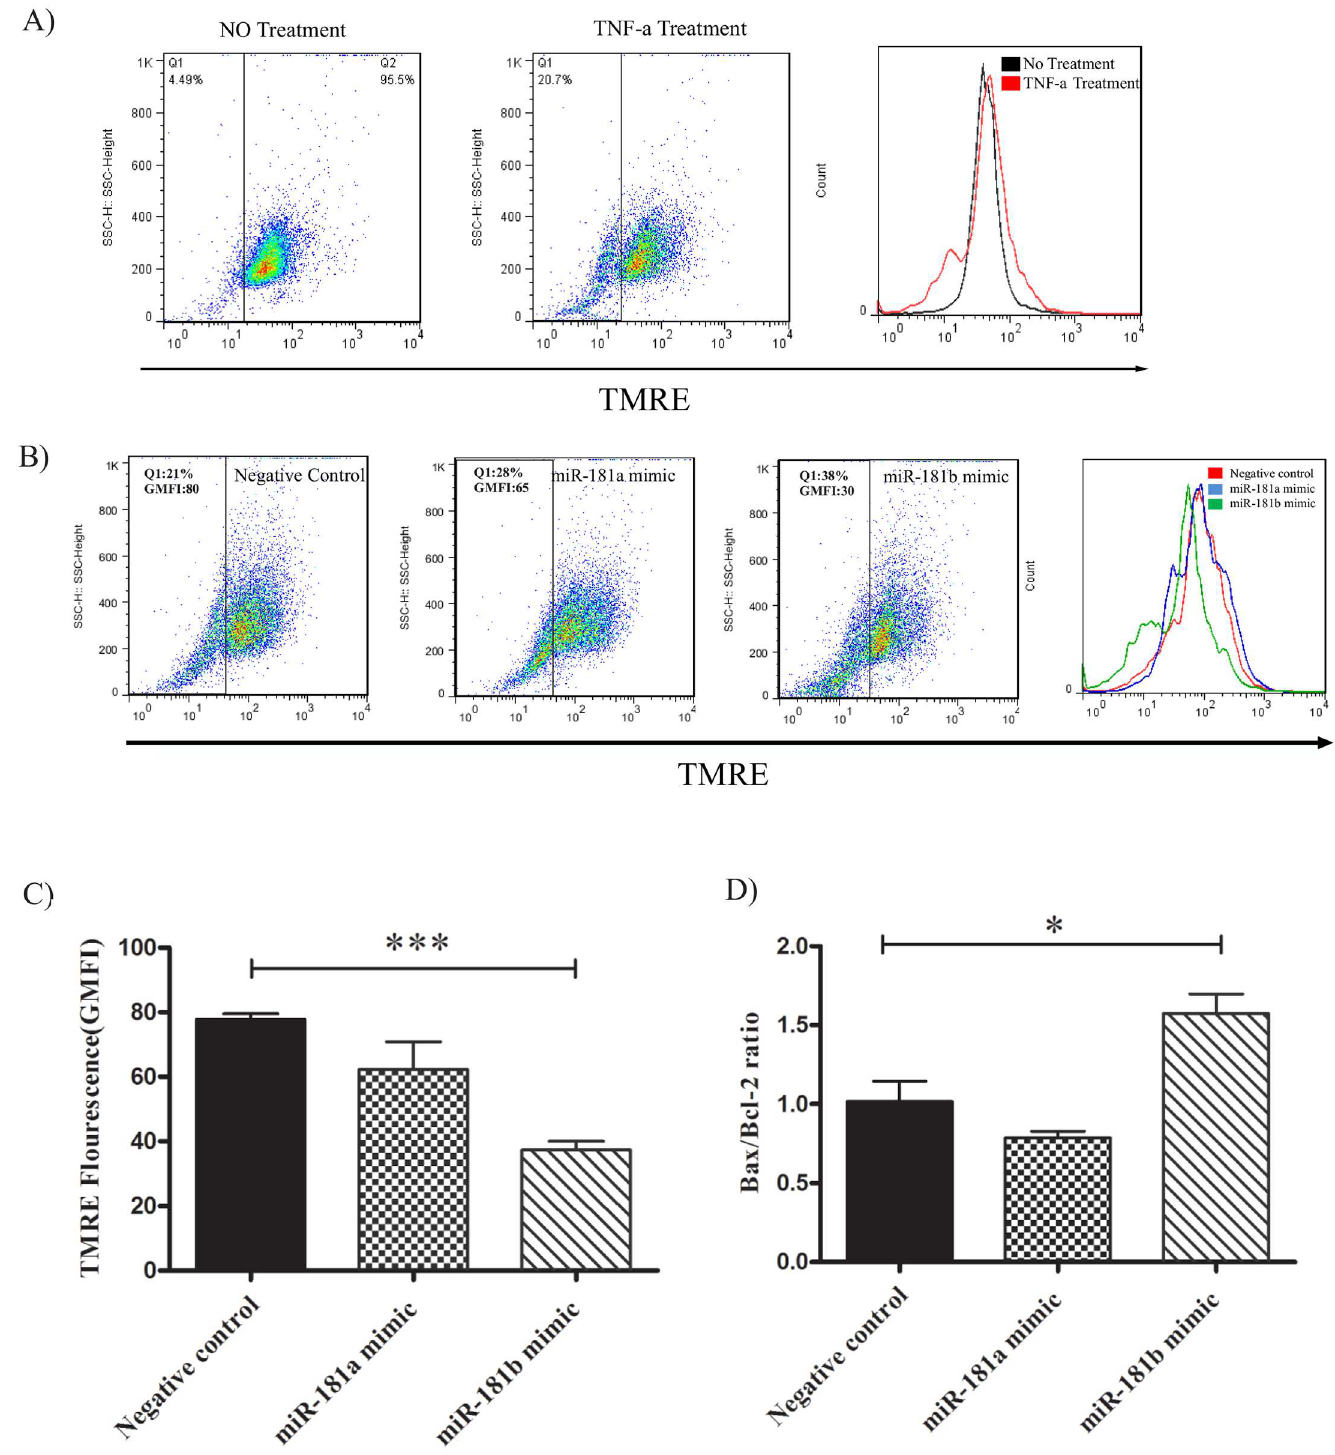
Fig 4. miR-181b overexpression decreasescell mitochondrial membrane potential. Followingtransfection of L929 cells with miR-181a,miR-181b mimics and negativecontrol miRNA mimic (50nM) for 24 hours, cells were treated by TNF- α (50ng/ml) for 3 hours and then stained with TMRE. Quantitative analysisof Bax and Bcl-2 mRNA expressionwas also performed post TNF- α treatment (30 minutes) using Real time PCR A) TMRE histogram of untreated and TNF- α treated cells B) Representative flow cytometry plots of transfected cells with miRNA mimics followingTNF- α exposure C) Geo mean fluorescent intensity of transfected cells with miR-181aand miR-181bmimics and negativecontrol. D) Bax/Bcl-2 ratio following overexpression of miR-181aand miR-181b.Data are shown as means + SEM ( n = 5). ANOVA, Tukey post hoc * p < 0.05, *** p < 0.000.